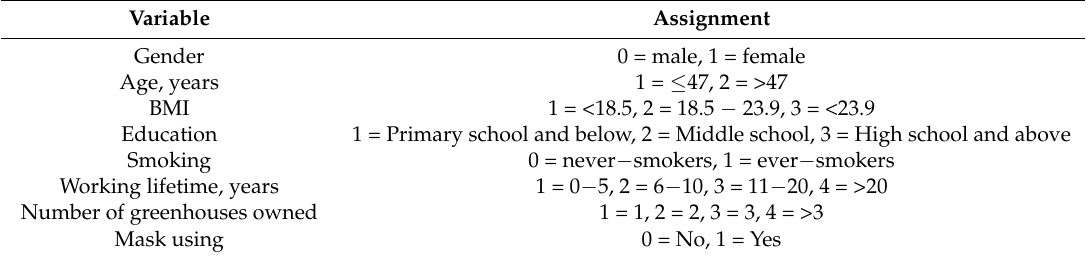
Table A2. Variable assignment of independent variables of logistic regression analysis.